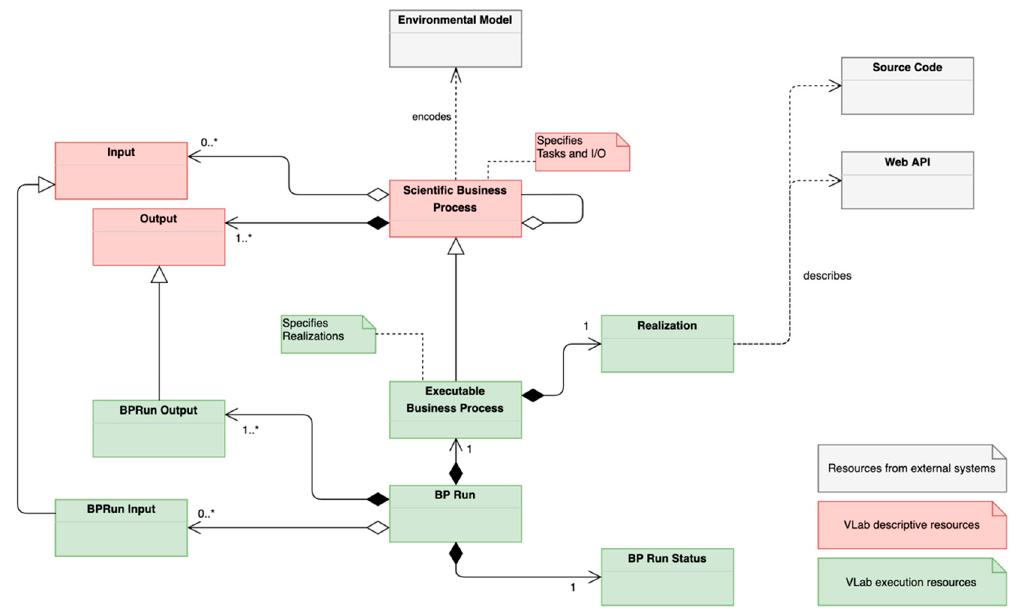
Figure 4. VLab Information Model.